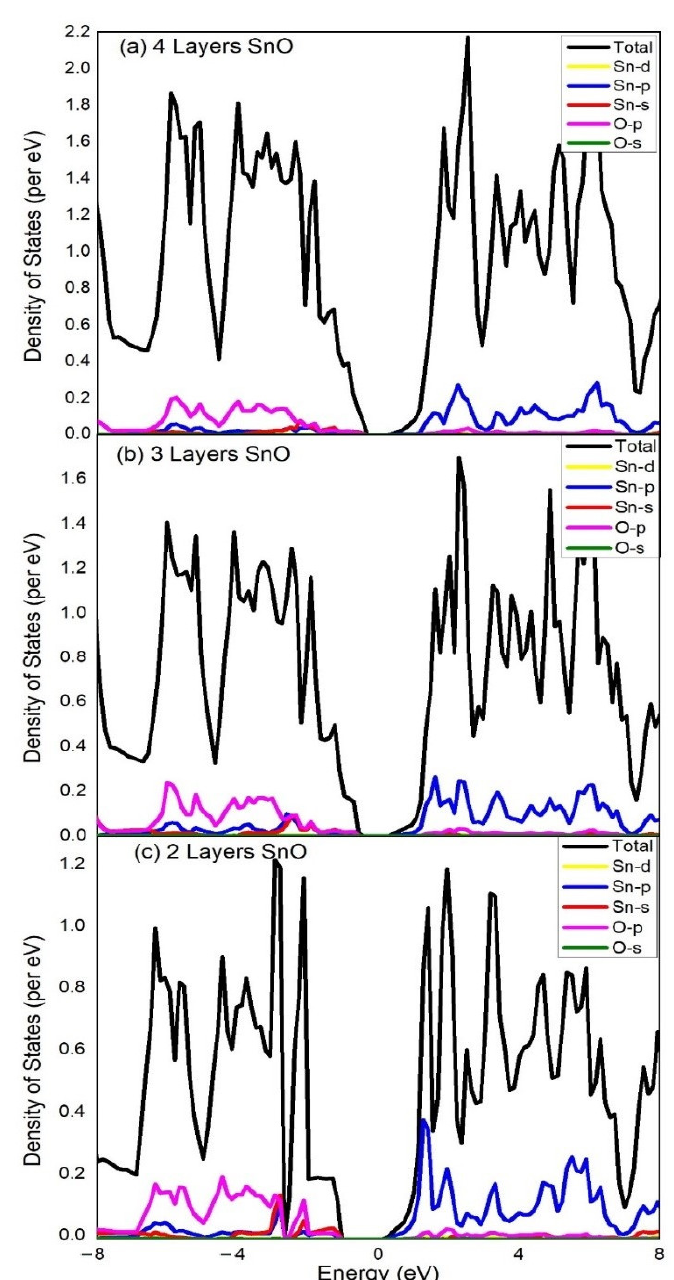
Figure 6. Total Density of States (TDOS) and Partial Density of States (PDOS) were calculated for ( a ) 4 layers, ( b ) 3 layers and ( c ) 2 layers of SnO. The Fermi level is adjusted at 0 eV, whereas the colored lines represent states per mentioned labels.